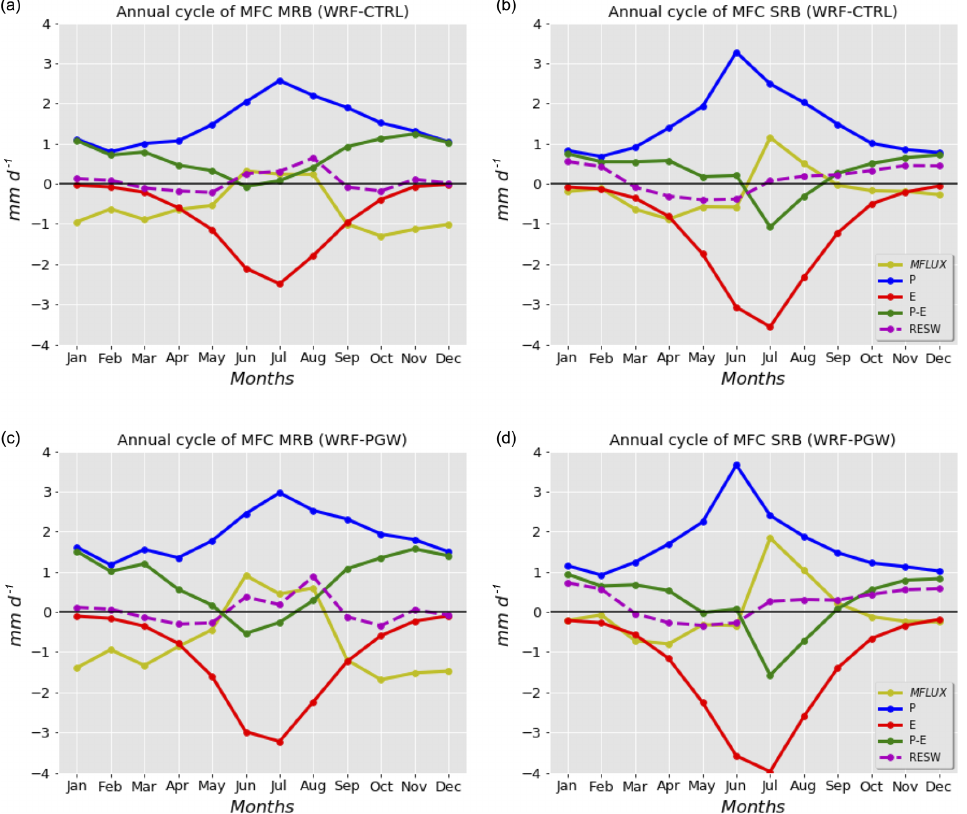
Figure 6. Atmospheric water vapour budget (mmd − 1 ) in WRF–CTL (a, b) and WRF–PGW (c, d) in MRB (a, c) and SRB (b, d) . MFLUX denotes the vertically integrated moisture flux convergence (MFC).